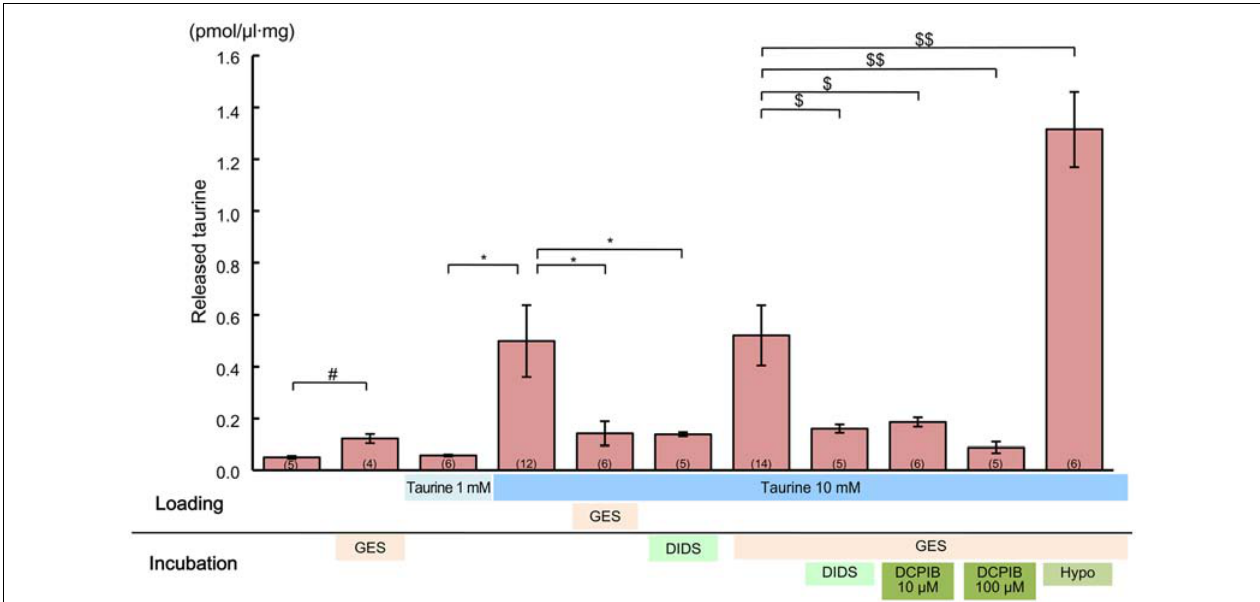
FIGURE 11 | Effects of anion channel blockers on taurine release in the developing neocortex. Each bar represents the taurine concentration determined via HPLC in the measurement medium containing cortical slices from GAD67 + / + fetuses at E17.5, either without or with the inhibitors indicated below the bar (“incubation”). The loading conditions, either without or with taurine (1 or 10 mM) and/or GES